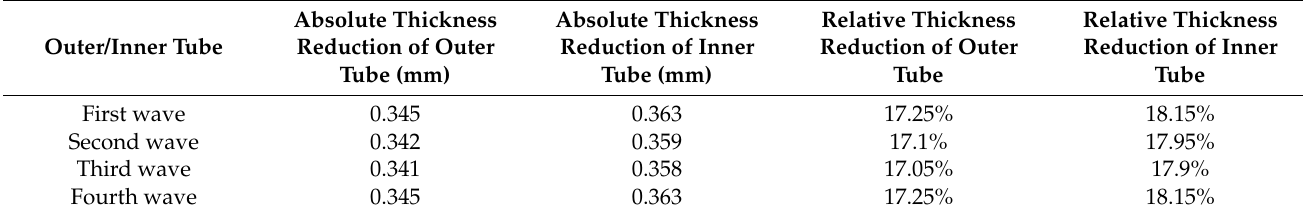
Table 3. Wall thickness reduction of the bellows.